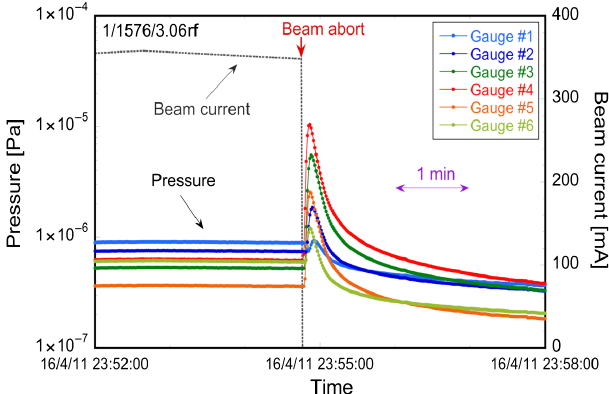
FIG. 23. Typical pressure bursts accompanied by beam loss (beam abort) observed in Phase-1